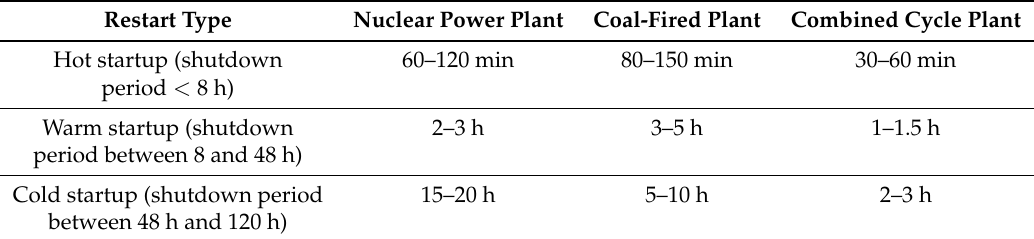
Table 3. Startup characteristics for nuclear, coal and combined cycle power plants